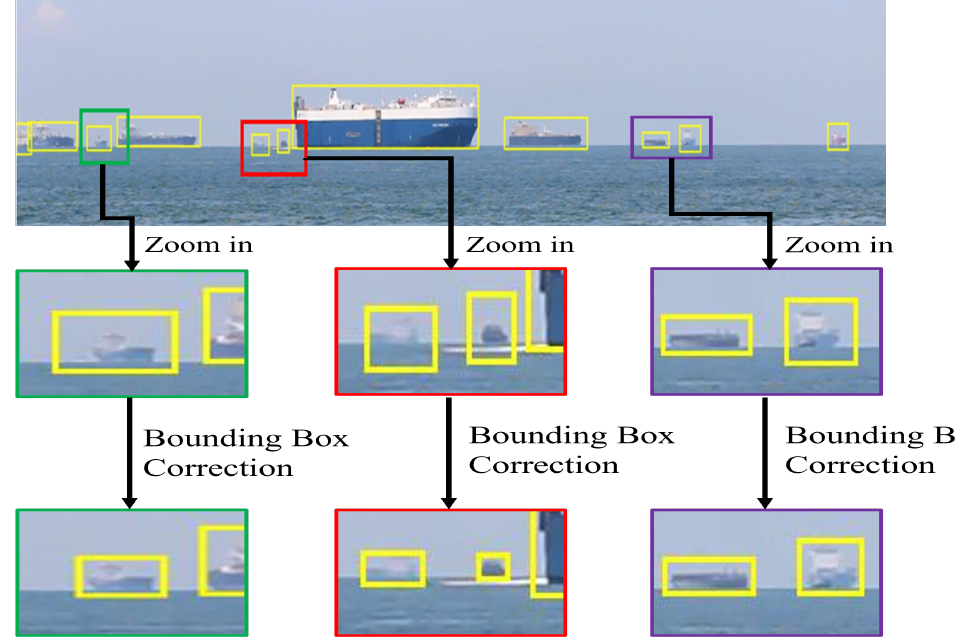
Figure 1. The original bounding boxes of the original SMD in the top image are refined in those at the